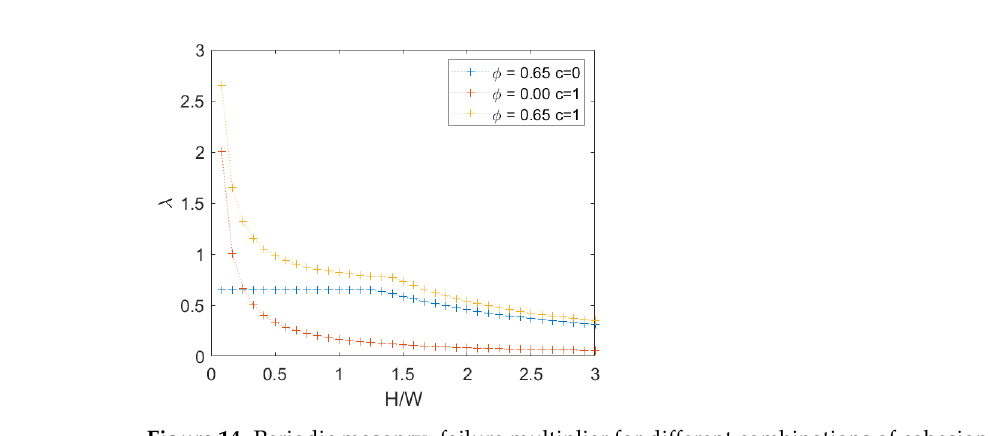
Figure 14. Periodic masonry: failure multiplier for different combinations of cohesion c and internal friction angle ϕ .